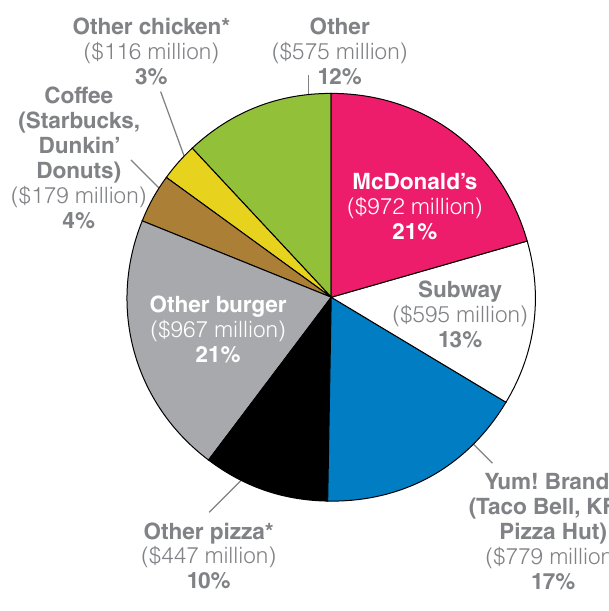
Figure 6. Total fast food advertising